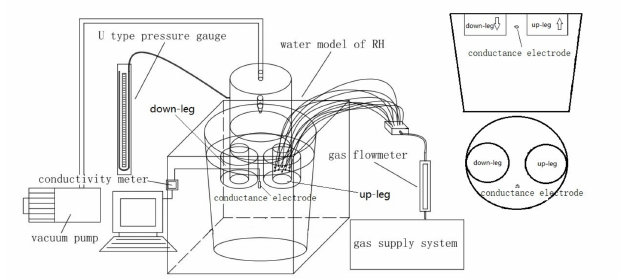
Figure 1. Schematic of the experimental